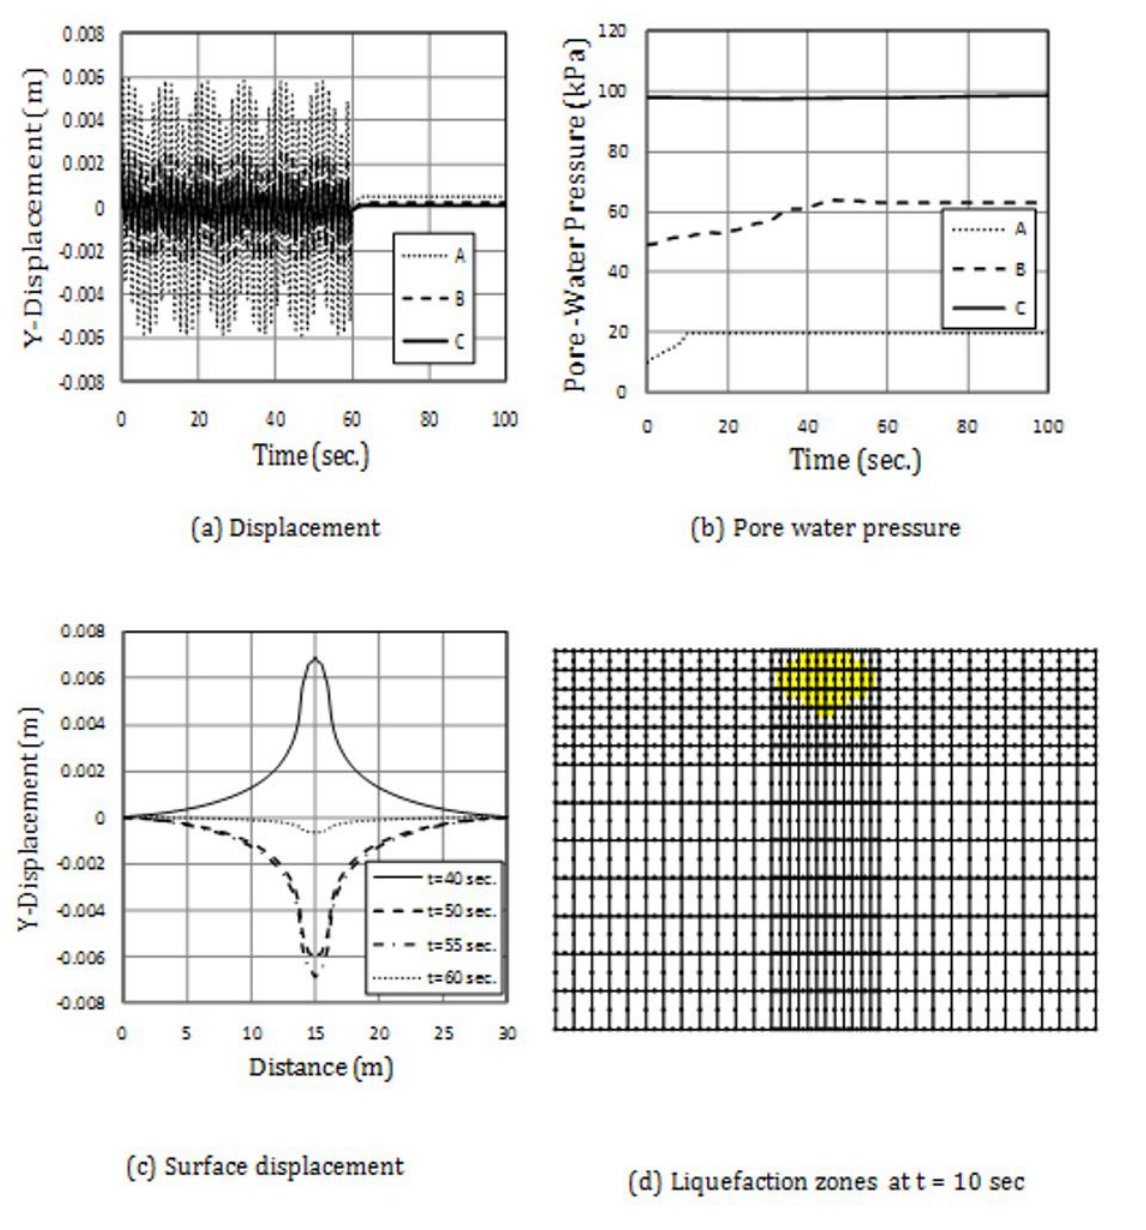
Figure 11. Dynamic response of the foundation to harmonic load, a